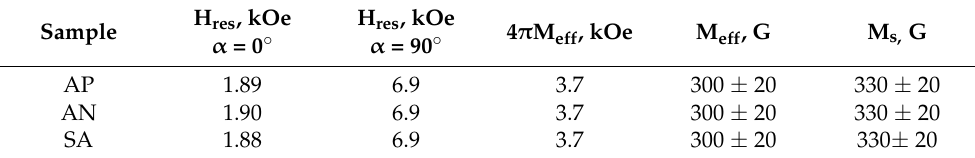
Table 2. Selected parameters of FMR measured for Fe 3 Co 67 Cr 3 Si 15 B 12 amorphous ribbons in different states AP, AN and TMT for the frequency f = 9.39 GHz. H res —FMR resonance field; α = 0 ◦ —in-plane configuration, α = 90 ◦ —out-of-plane configuration; M eff —effective magnetization obtained from FMR measurements and M s —saturation magnetization obtained from VSM